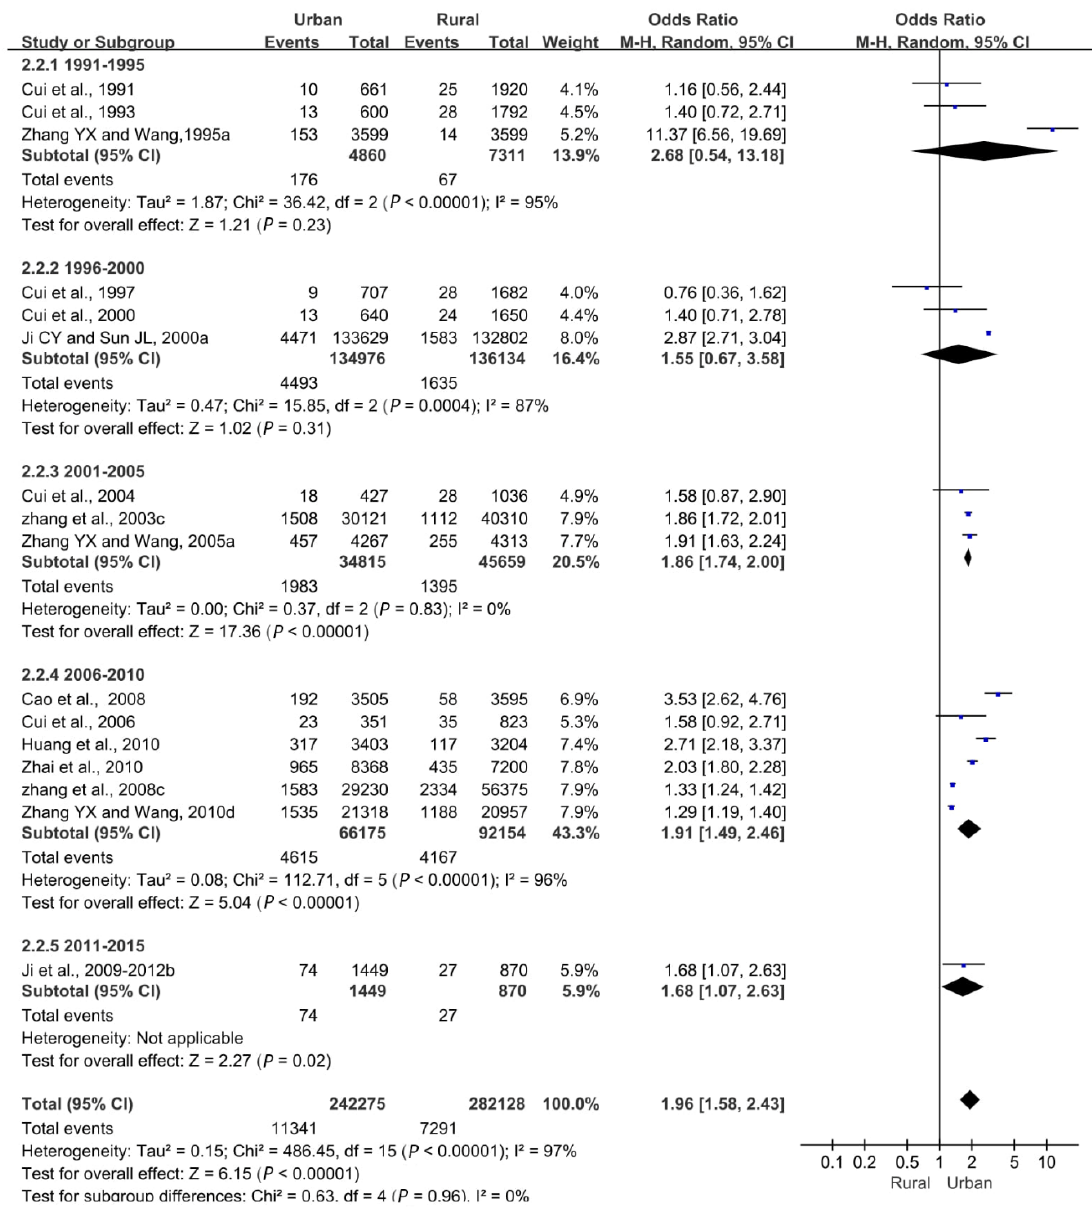
Figure 5. Forest plot of obesity in urban children and adolescents compared with rural children and adolescents aged 0 – 18 years.